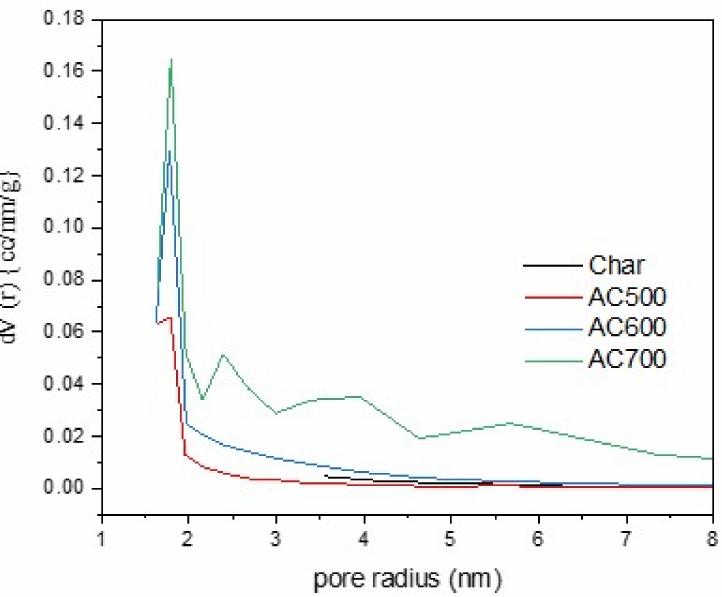
Figure 7. The pore distribution curve of the activated-carbon compared with the carbonized bagasse. The MB adsorption on AC700 for various initial concentrations reaches equilibrium af- ter 30 min (Figure 8). Table 3 lists the equilibrium concentration, Ce, and the mass adsorbed at equilibrium, q e , for each initial concentration, along with the isotherm parameters. The theoretical maximum adsorption capacity of the AC700 adsorbent is 303 mg/g adsorbent, based the surface area of AC700 and the covered area of MB molecules [31]. However, the Langmuir isotherm found a maximum loading of MB molecules on the AC700, a , of 21.008 mg/g.